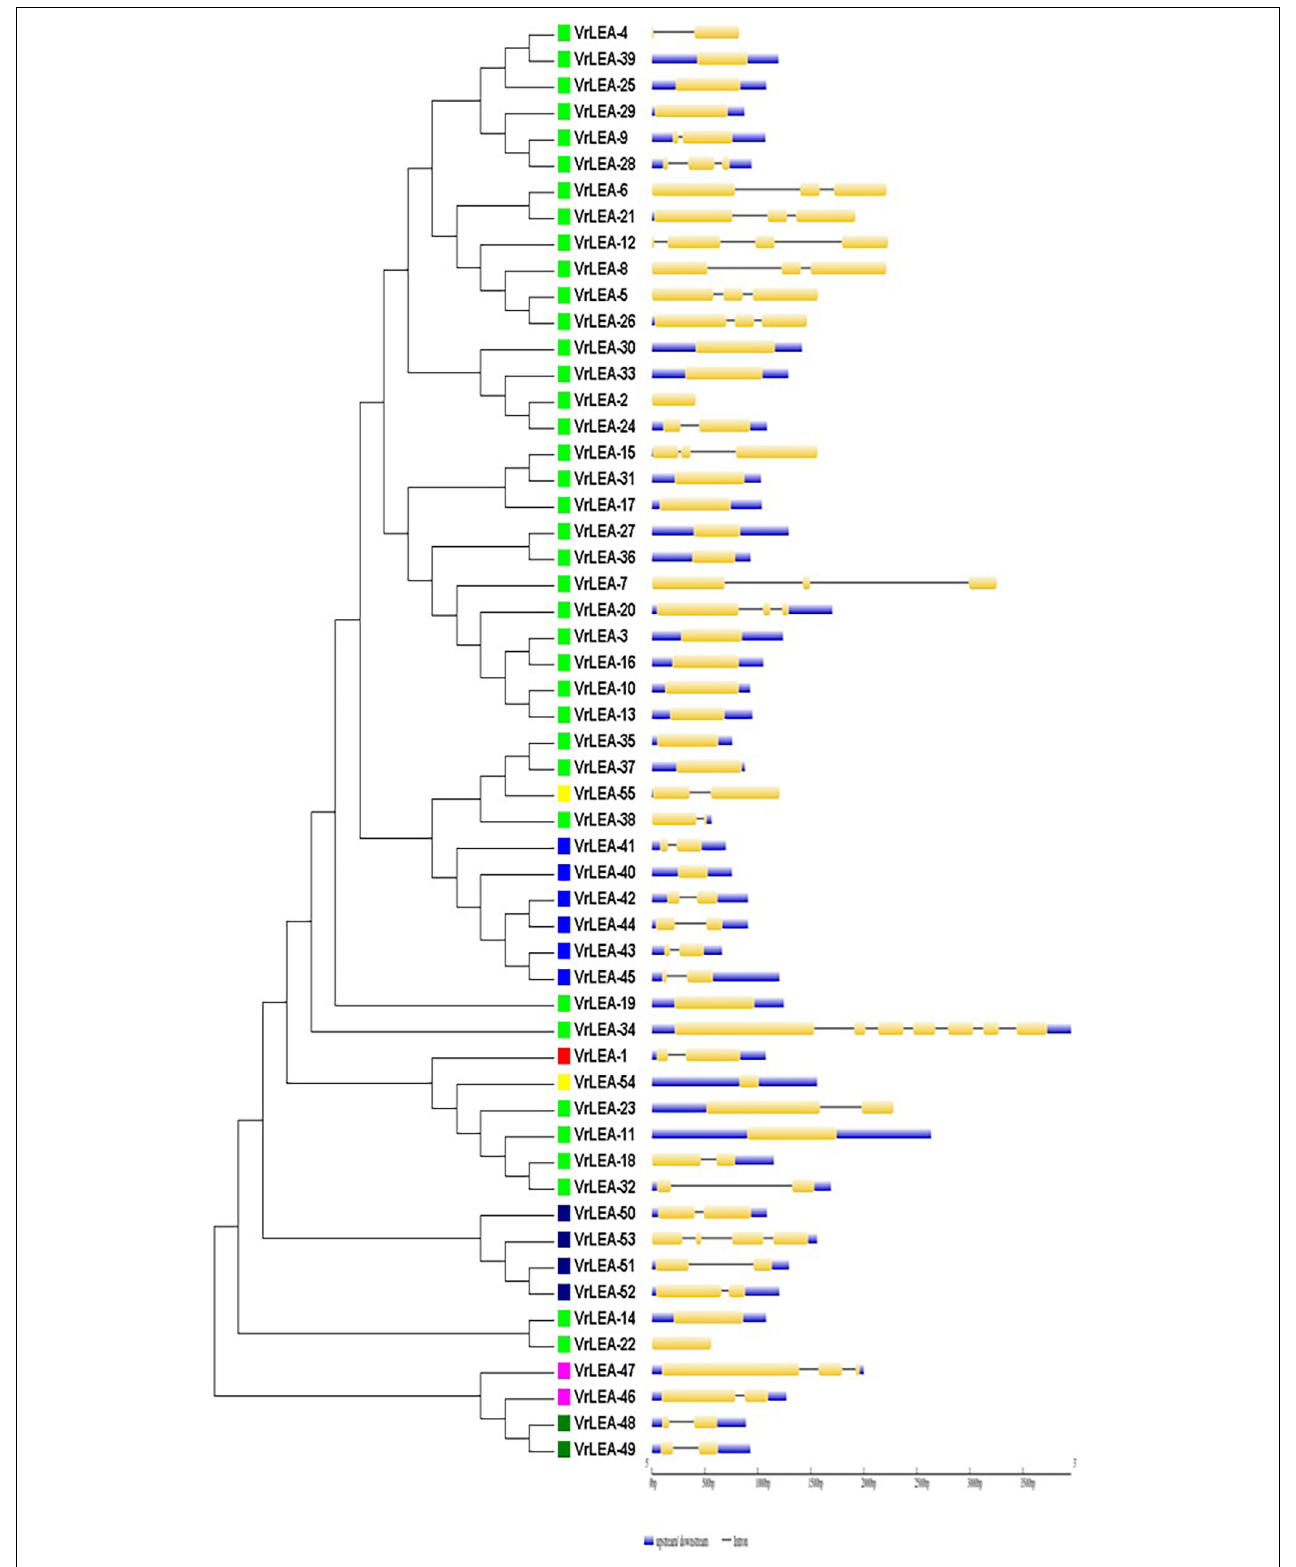
FIGURE 3 | Intron-exon gene structure analysis of VrLEA genes.